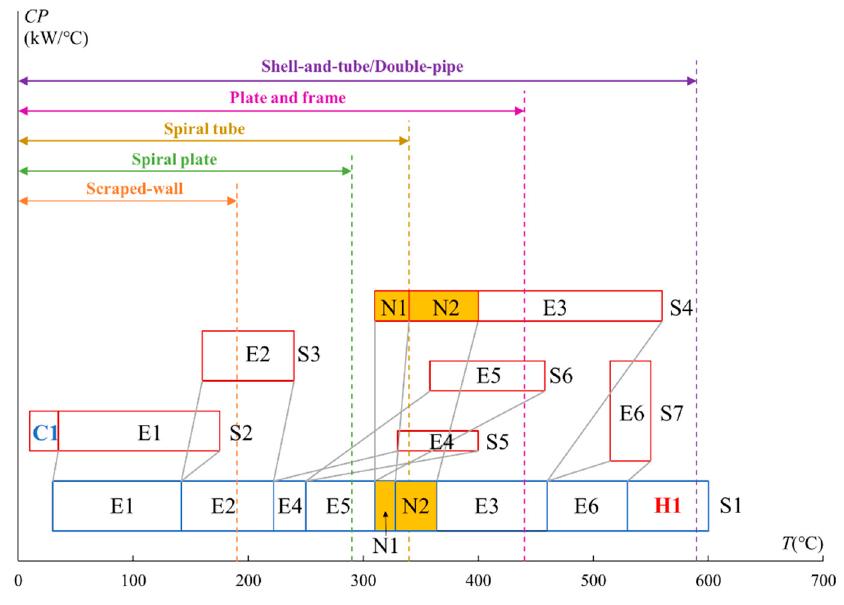
Figure 10. SRTGD-STR if two heat exchangers are added for this case study. Table 6. Comparison of the results for the case study.